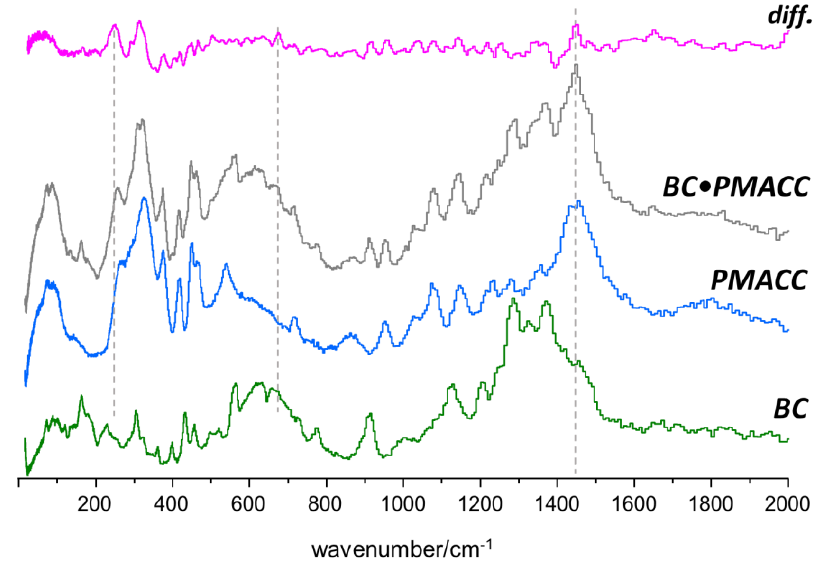
Figure 6. INS spectra of BC • PMACC nanocomposite, PMACC, and BC in the 20–2000 cm − 1 range. The top line is the difference between nanocomposite spectrum (BC•PMACC) and the weighted sum of pure components spectra (PMACC + BC).